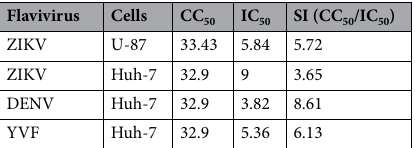
Table 1. Selectivity index of MET. Cytotoxicity (CC 50 ), anti-flavivirus activity (IC 50 ), selectivity index